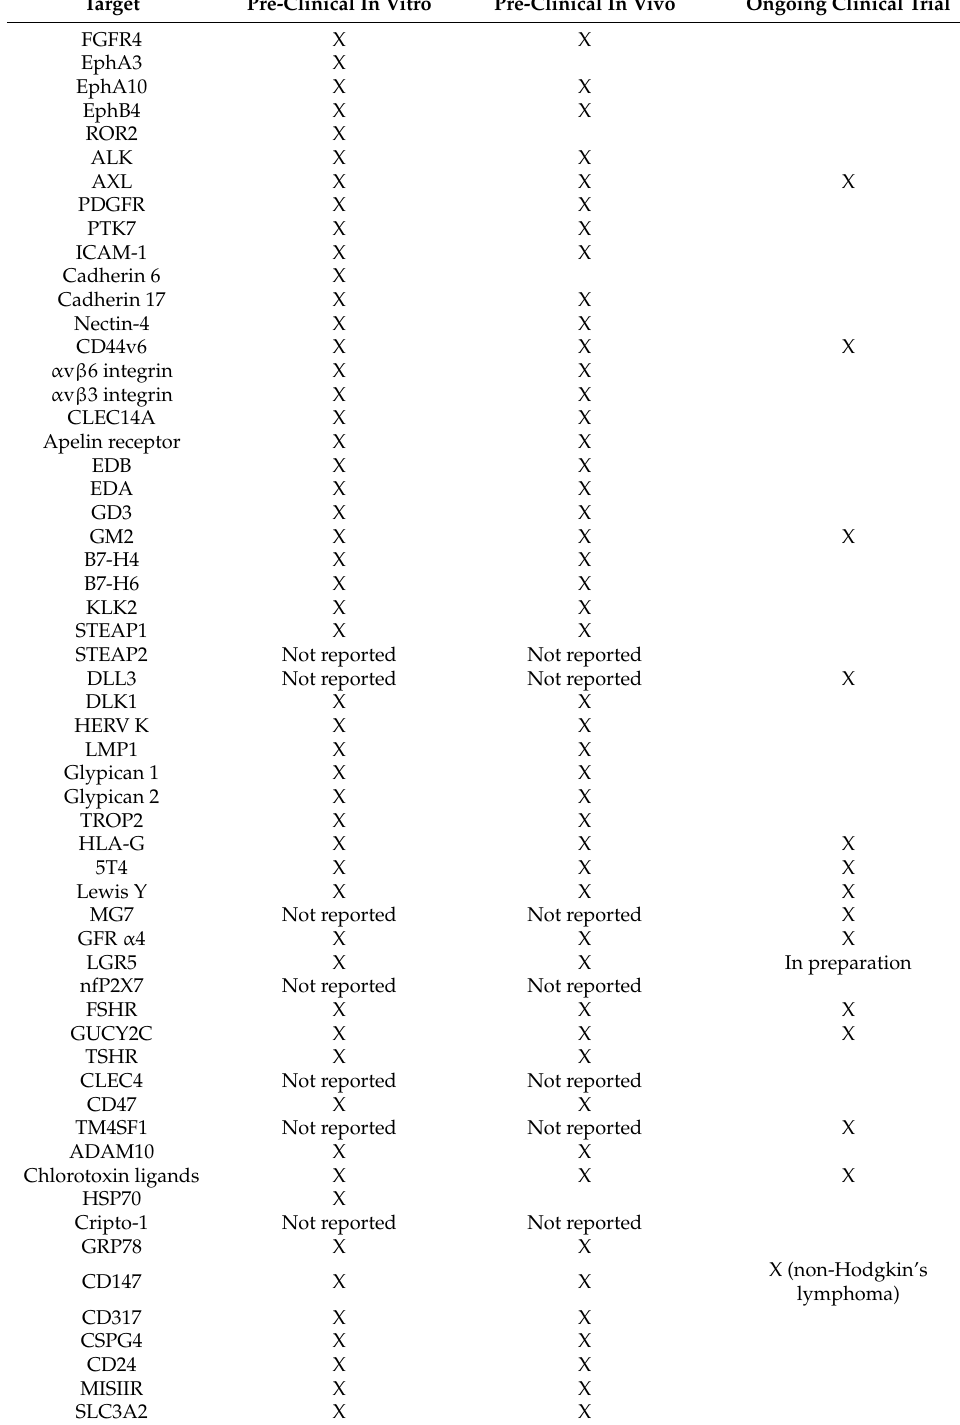
Table 2. Non-clinical and ongoing clinical evaluation of emerging solid tumour CAR